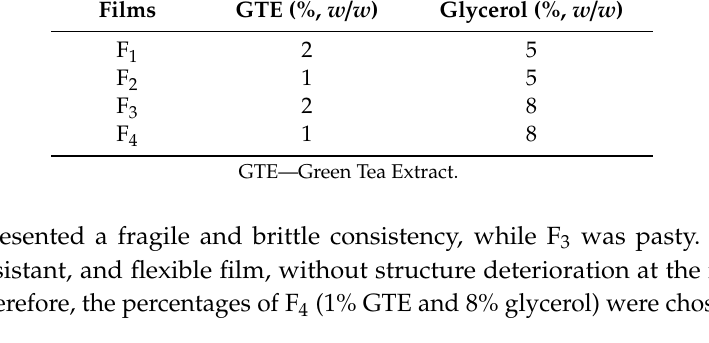
Table 3. Films tested for the optimization of glycerol and green tea extract.